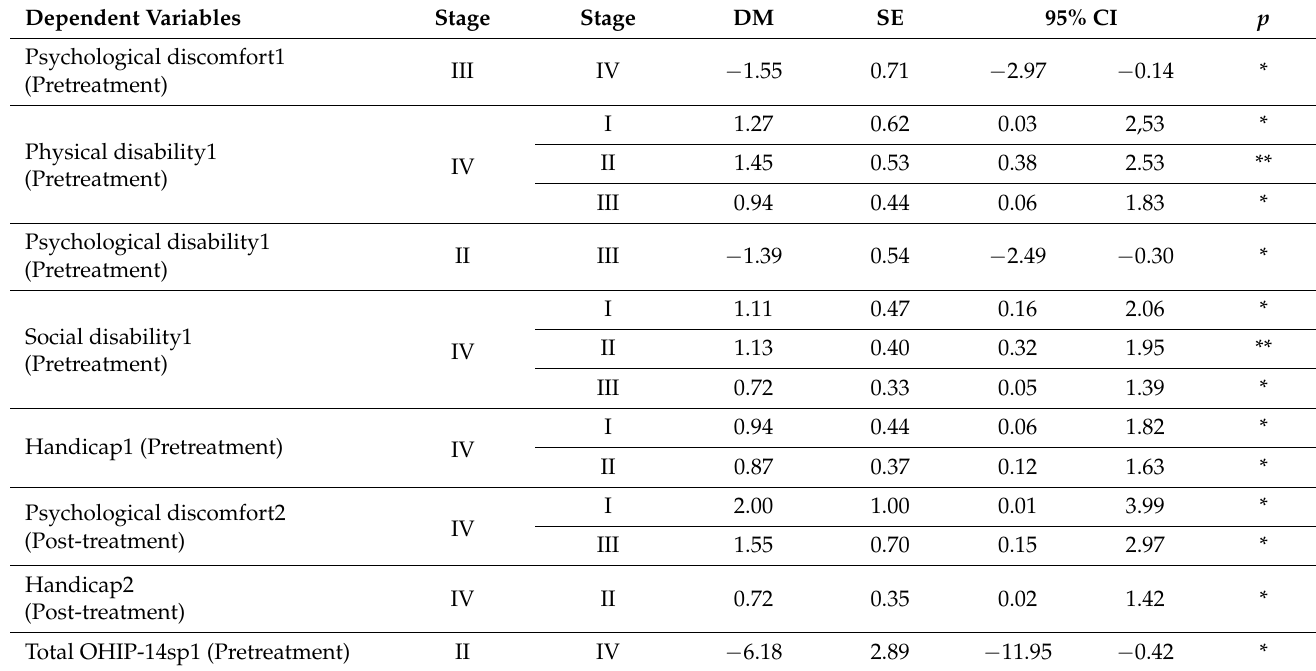
Table 3. ANOVA of the significant dependent variables (pretreatment:1 and post-treatment: 2) with respect to the stage of periodontal disease (I, II, III, IV).